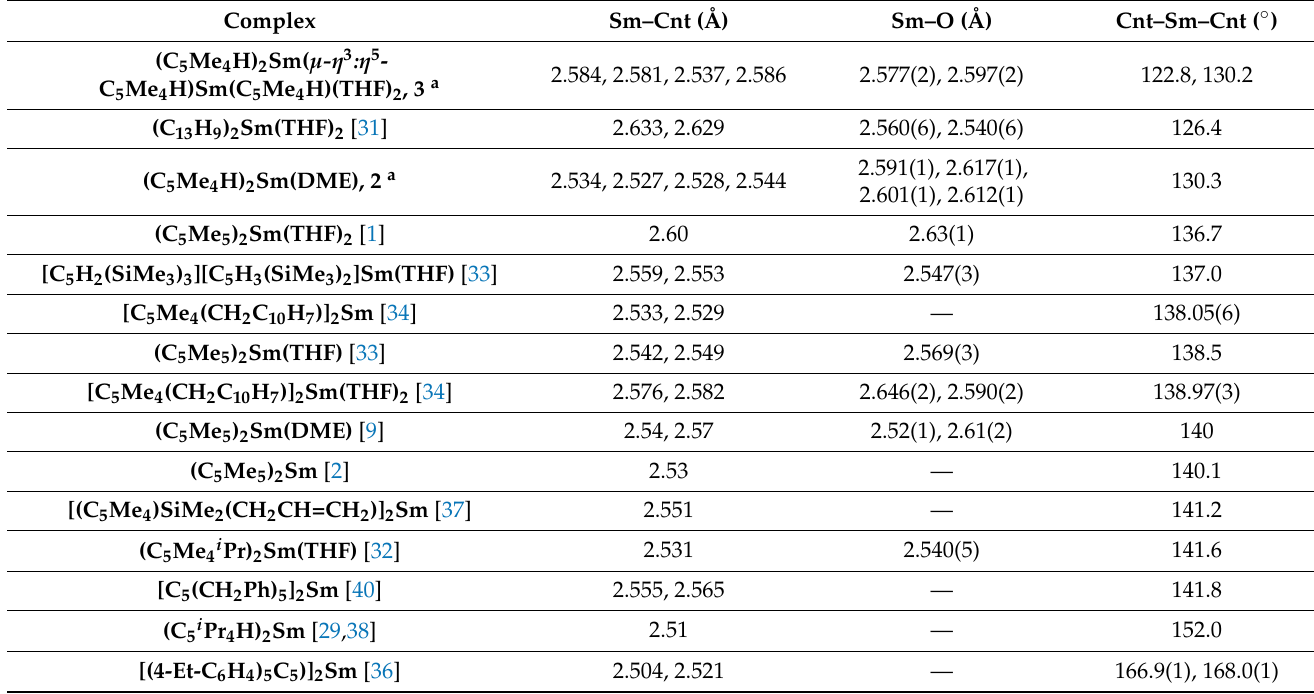
Table 2. Comparison of Sm–Cnt (Å) and Sm–O (Å) distances and Cnt–Sm–Cnt angles ( ◦ ) for various crystallographically characterized Sm(II) metallocenes in order of increasing Cnt–Sm–Cnt angle. Complex